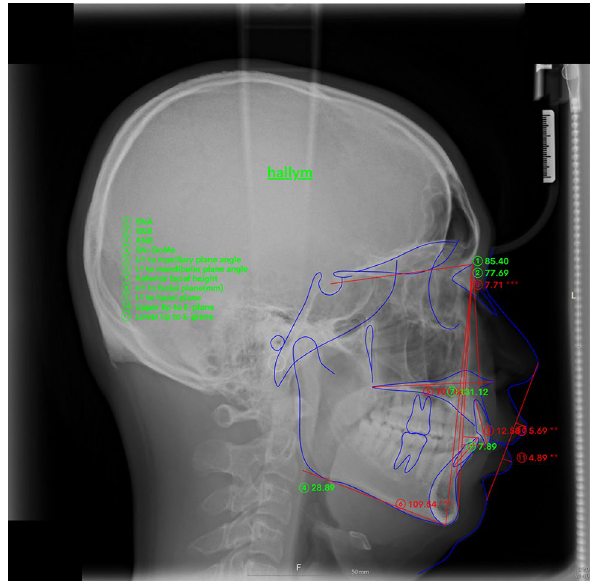
Figure 2. Major landmarks used in this study with AI-based tracing